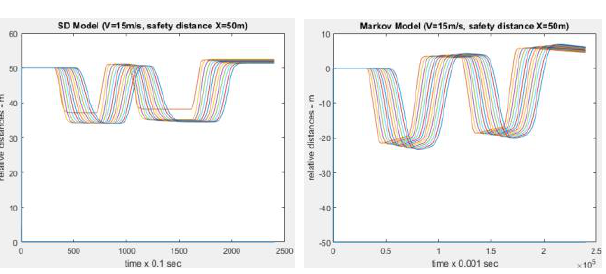
Fig. 22. The impact of the initial conditions on the relative